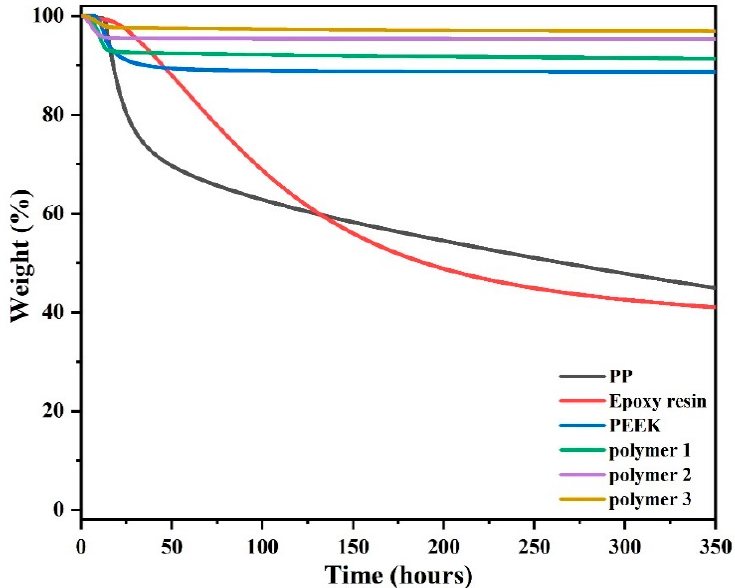
Figure 17. Long-term stability of five materials in an inert atmosphere at 300 °C.